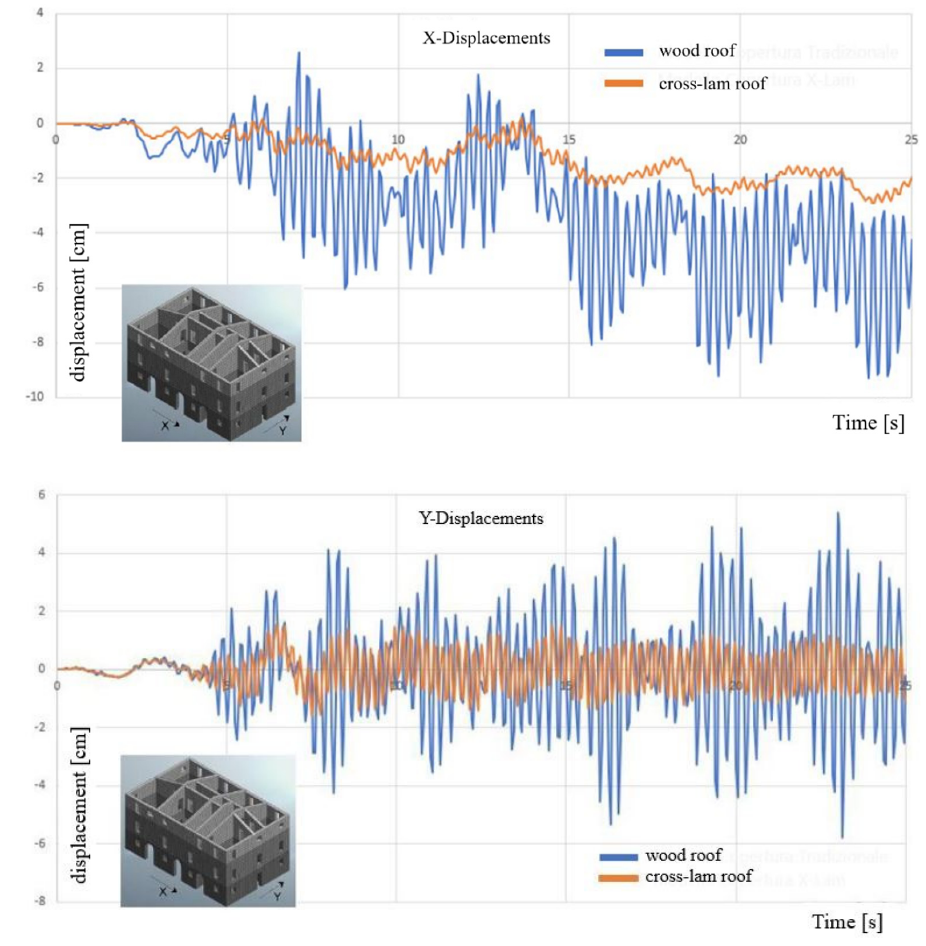
Figure 17. Comparison between the obtained maximum displacements of the roofs in X and Y di- rection considering the cross-laminated roof structure (14 cm thickness) and a single plank wooden roof (4 cm